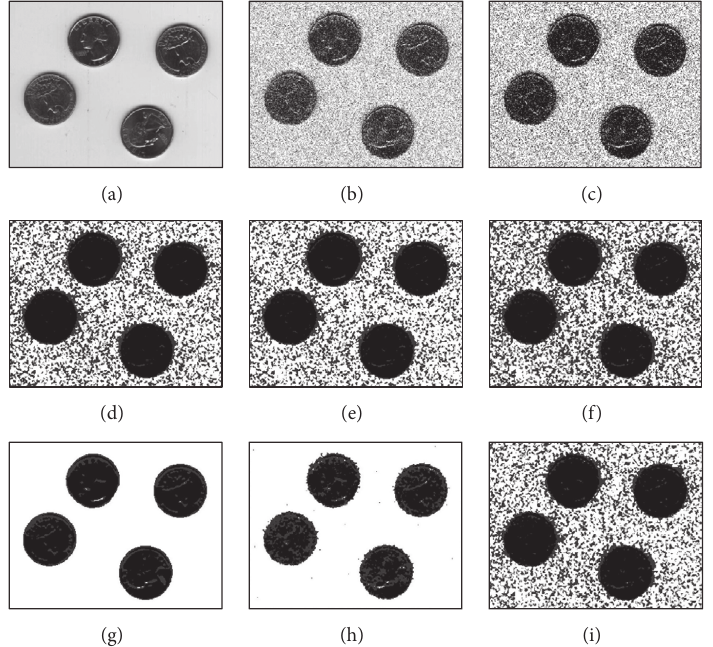
Figure 4: Segmentation result on eight image. (a) Originale image. (b) Image corrupted by 30% of Gaussian noise. (c) FCM result. (d) FCM S result. (e) FCM S1 result. (f) FCM S2 result. (g) RFCMLGI result. (h) RFCMLGI 1 result. (i) RFCMLGI 2 result.